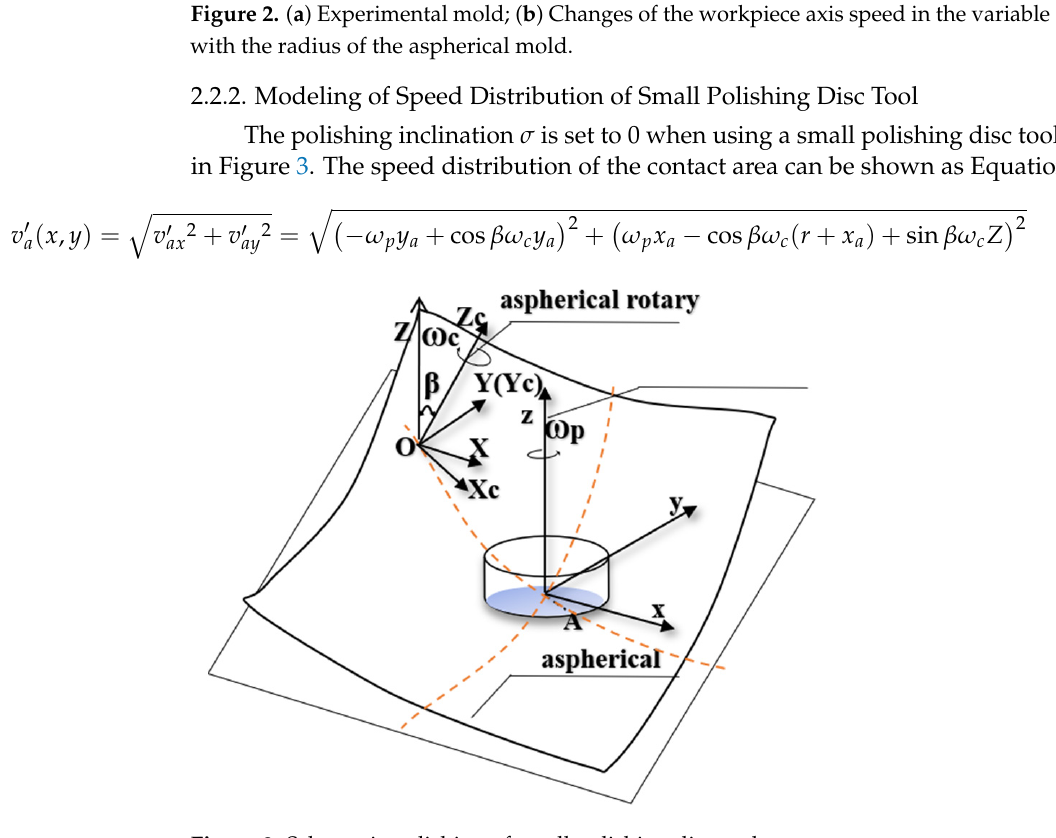
Figure 3. Schematic polishing of small polishing disc tool.